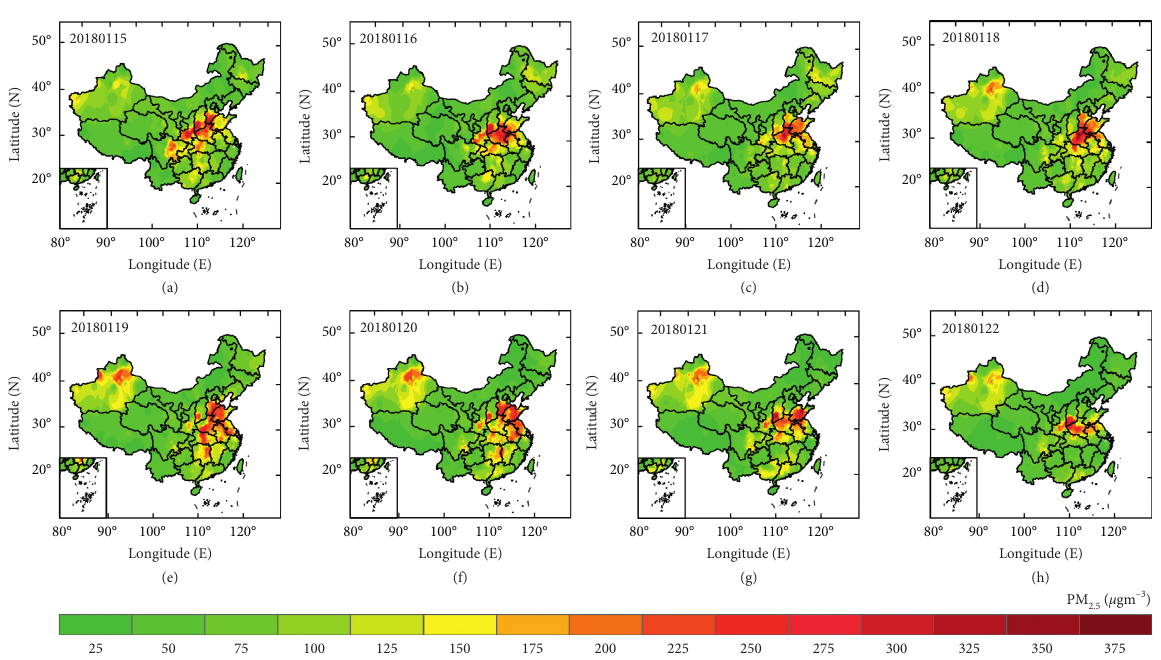
Figure 2: Spatial distribution of PM